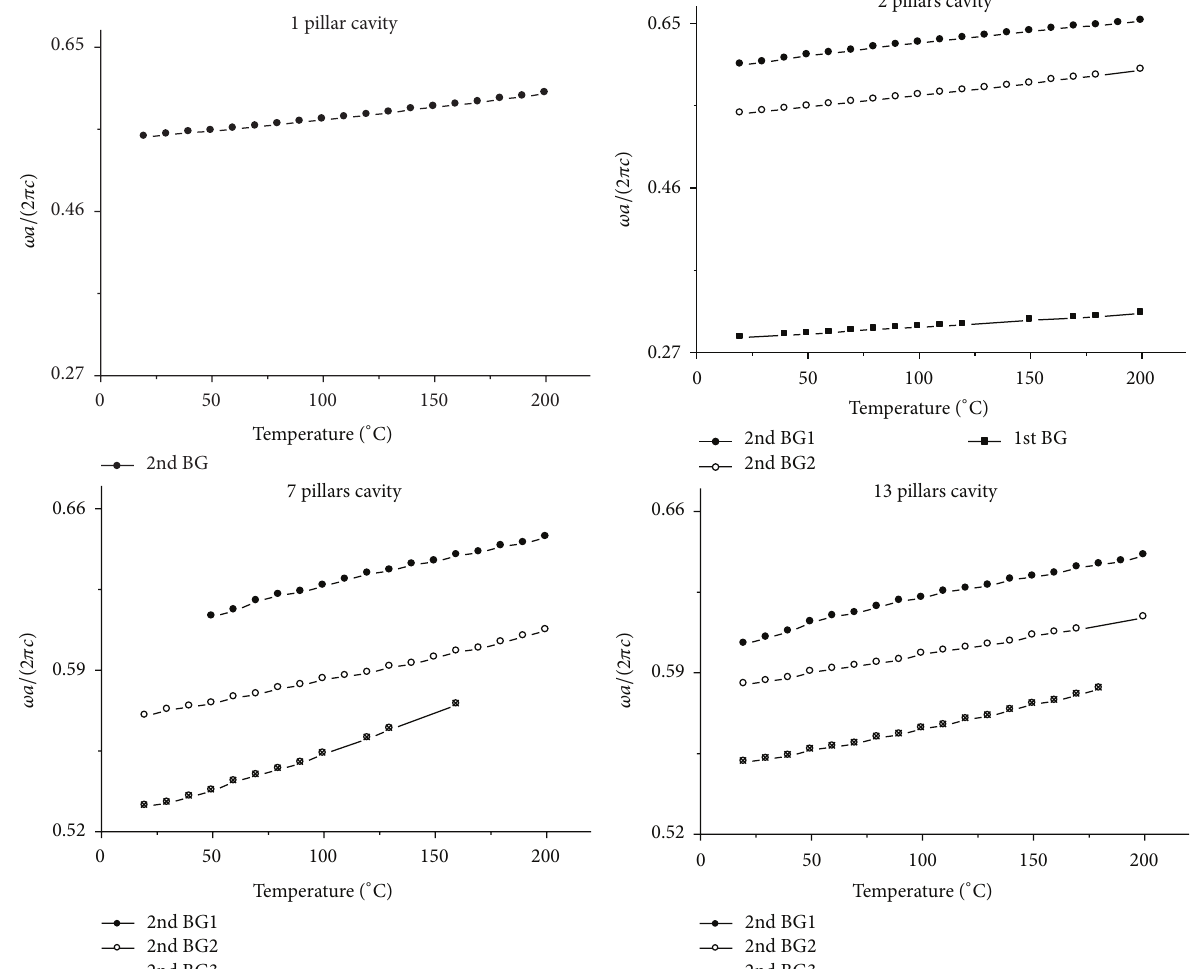
Figure 15: The resonant frequency change with temperature for 𝑛 pillars cavity. The four figures are the result for 1, 2, 7, 13 pillars cavity, respectively. The square and circle legends represent the curves which are localized in the first and the second band gap,